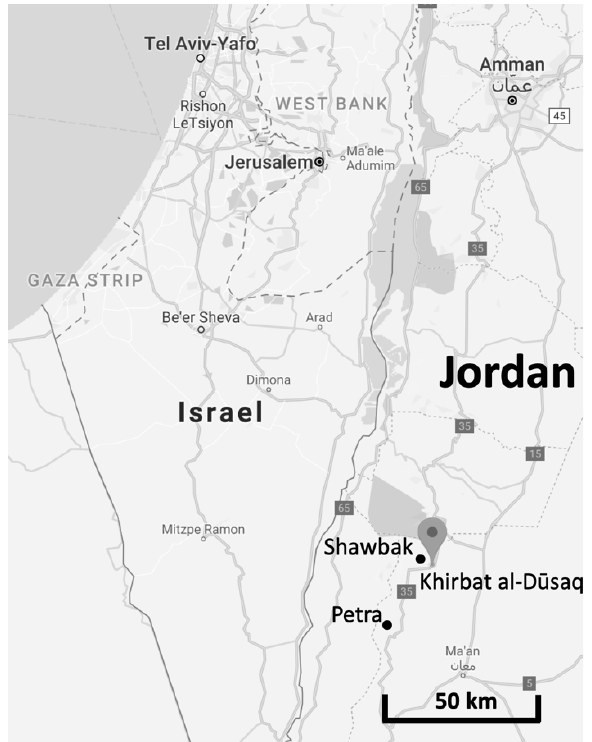
Figure 1: Khirbat al-D ū saq, Jordan (© google maps) The combination of the study of the architectural decorations